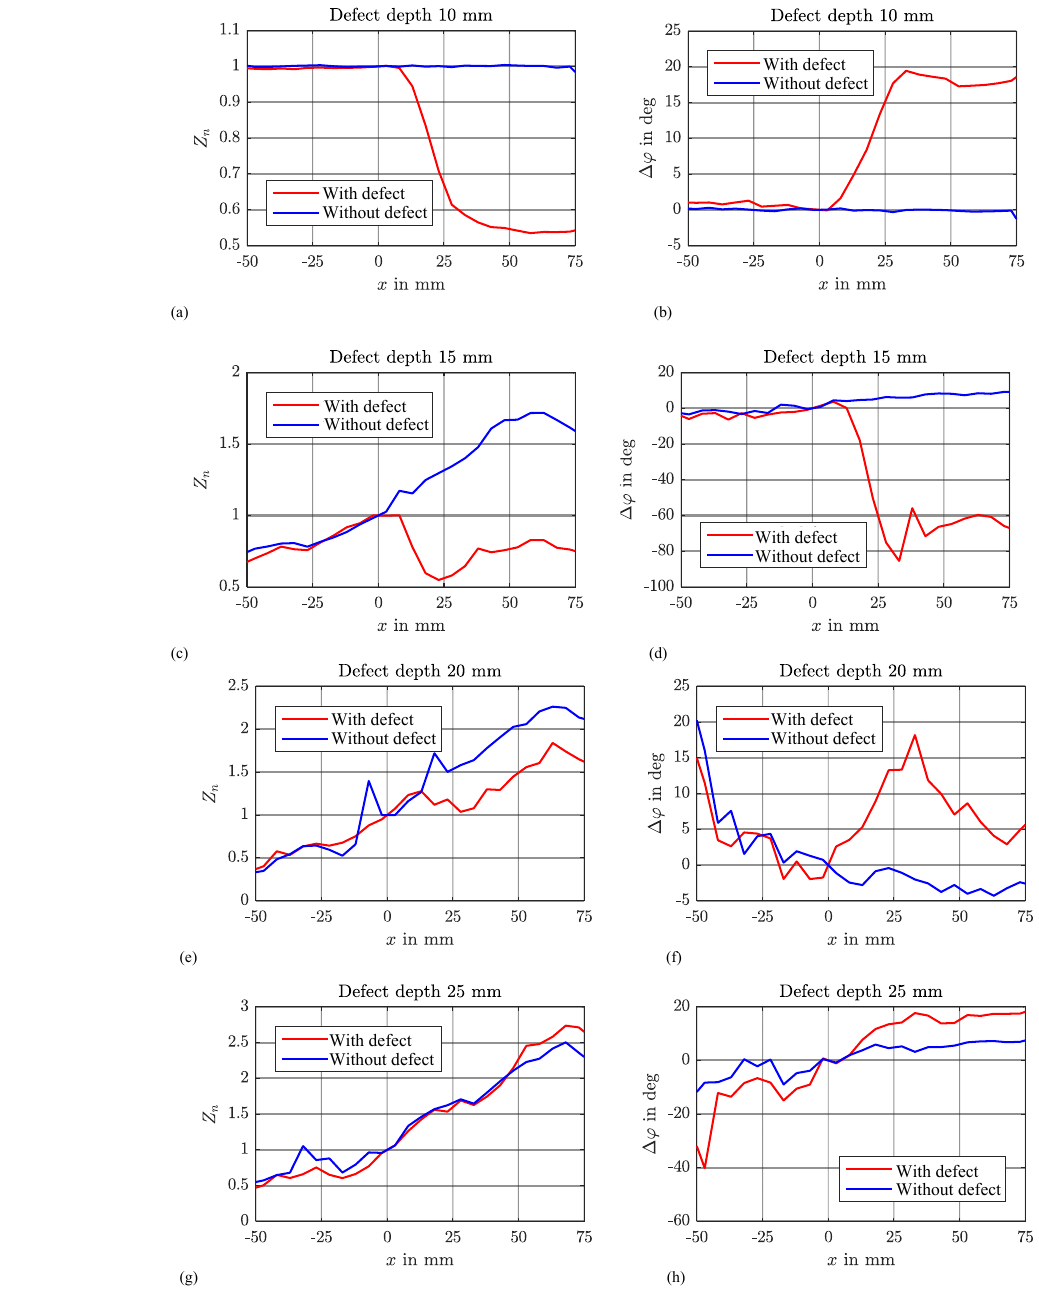
Figure 5. Normalized impedance Z n and phase difference for defect depths of d = 10mm (a, b) , d = 15mm (c, d) , d = 20mm (e, f) , and d = 25mm (g, h) for specimens with a defect (red solid line) and without a defect (blue solid line) of the ECT